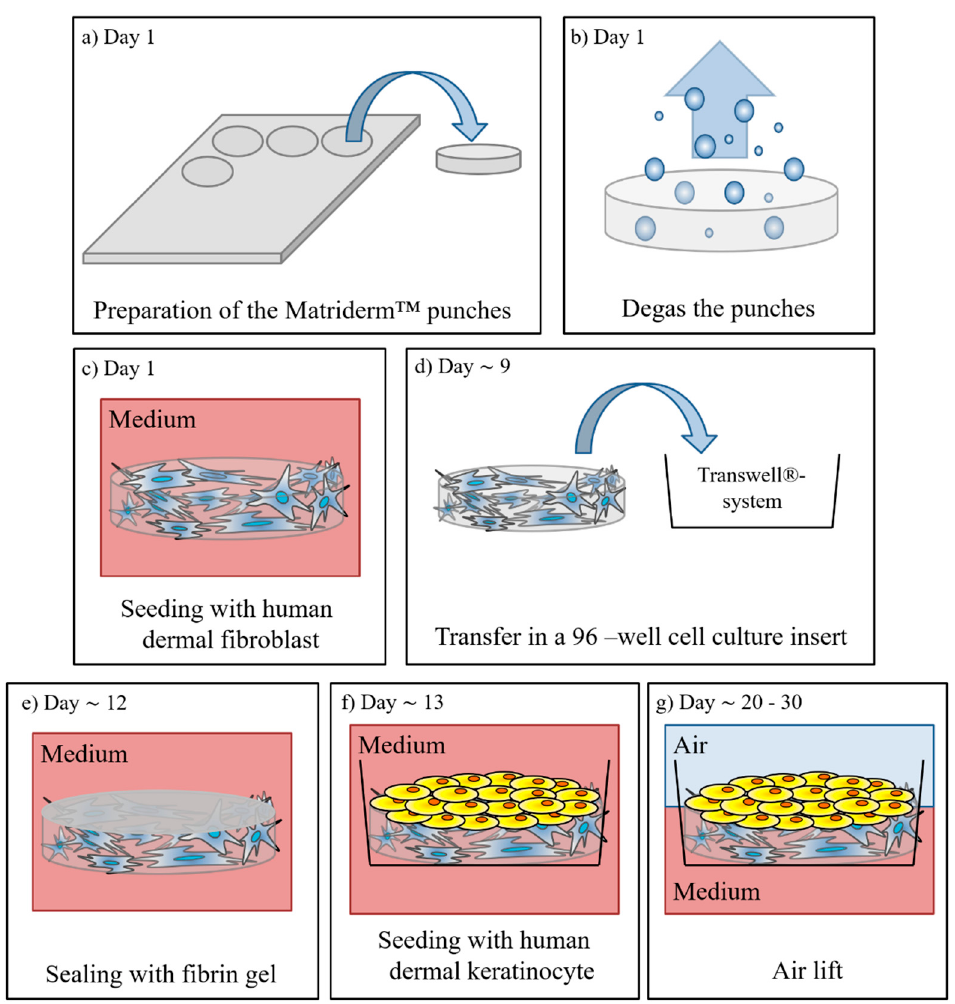
Figure 1. Schematic diagram of the ftSE cultivation. ( a ) Punches are cut out of the Matriderm™ matrix and ( b ) degassed in an exsiccator. ( c ) Then the matrix is seeded with human dermal fibroblasts. ( d ) On day nine, the ftSE is transferred into a cell culture insert system. ( e ) After four days of cultivation, the skin equivalent is sealed with a fibrin gel. ( f ) One day later, normal human keratinocytes are seeded onto the top of the equivalent. ( g ) On day 20, the equivalents are lifted to the air-liquid interface and cultivated further for ~10 days.